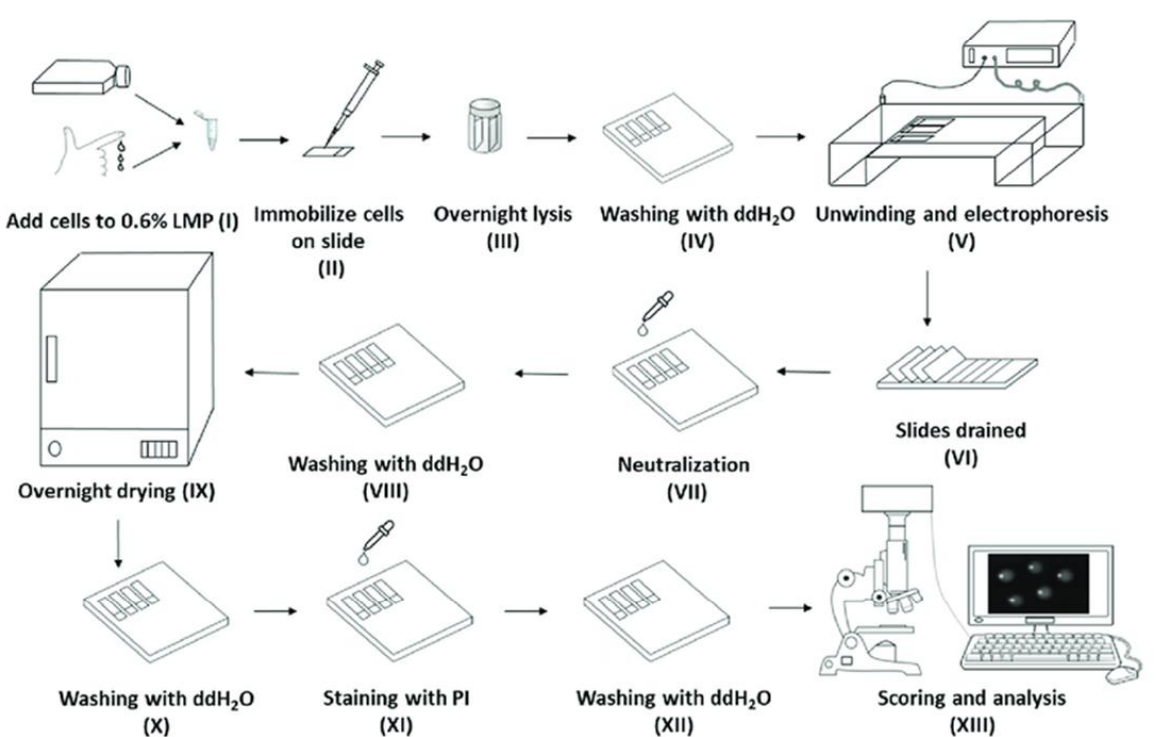
Figure 1. Overview of the alkaline comet assay [23]. ( I ) Cells are mixed with low-melting-point agarose prior to being ( II ) embedded onto 1% agarose pre-coated microscope slides. ( III ) The slides are then submerged in high pH lysis buffer and are then ( IV ) washed with water. ( V ) The slides are then placed in an electrophoresis buffer to allow DNA unwinding, and then undergo electrophoresis. The slides are then ( VI ) drained, ( VII ) neutralized, and ( VIII ) washed before ( IX ) drying. The slides are then ( X ) rehydrated and ( XI ) stained with a fluorescent dye, followed by another ( XII ) wash before being ( XIII ) “scored”, i.e., analyzed using fluorescent microscopy and image analysis software to quantify the damage.